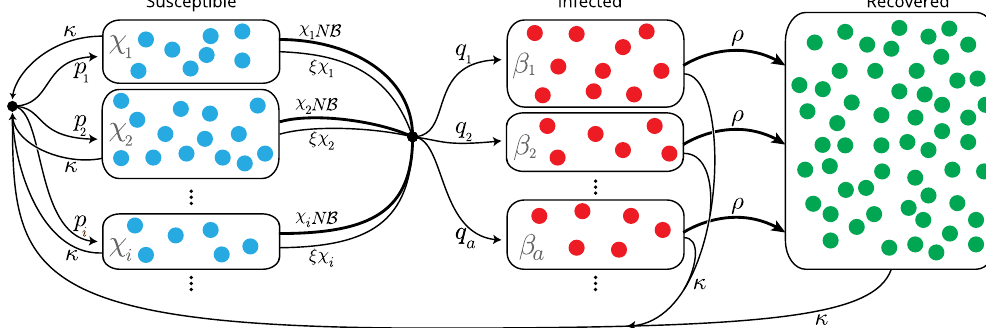
Figure 1. SIR model with heterogeneous susceptibility and infectivity. The diagram illustrates the different processes described by the model. New (susceptible) individuals are born at a rate κ , and they are assigned a susceptibility of χ i with probability p i . Susceptible individuals transition to an infected state either by spontaneous infection or by contact with any of the infected classes. The former process occurs with rate ξχ i , if the susceptible is of type S i . Conact infection occurs at a rate χ  N , where N  is the total infective power of the i population (see Eq. (3)). Once infected, the individual is assigned an infectiousness β a with probability q a . All infected individuals recover at the same rate ρ . At any stage, individuals die with a rate κ . To keep the total population N constant, deceased individuals are immediately replaced by a new susceptible